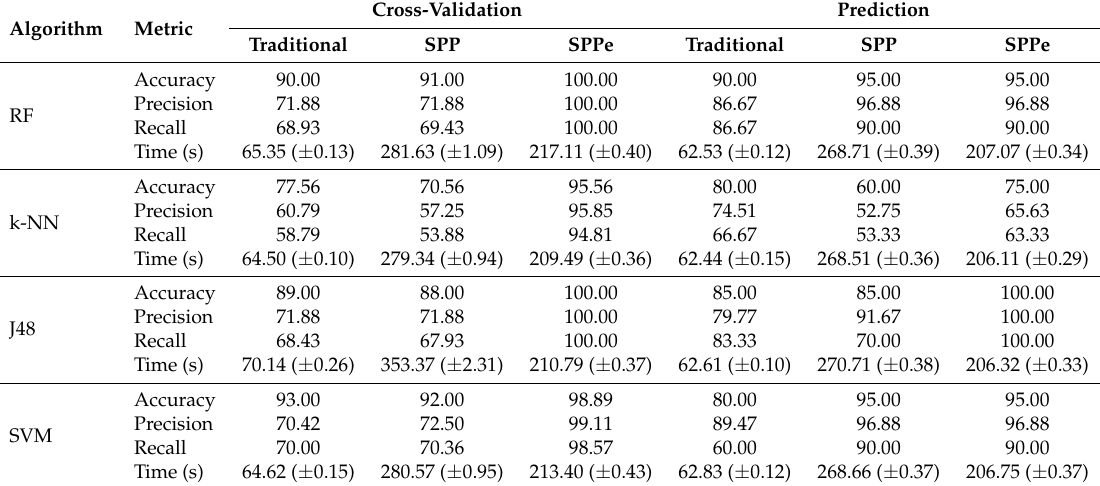
Table 4. Performance measures in the comparison of the methods and algorithms (RF, k-NN, J48 and SVM) over the cross-validation and prediction